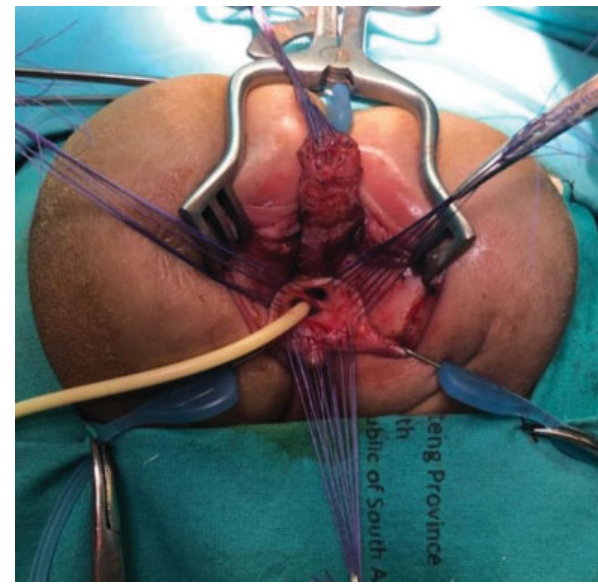
Fig. 2 External appearance of perineum and genitalia.